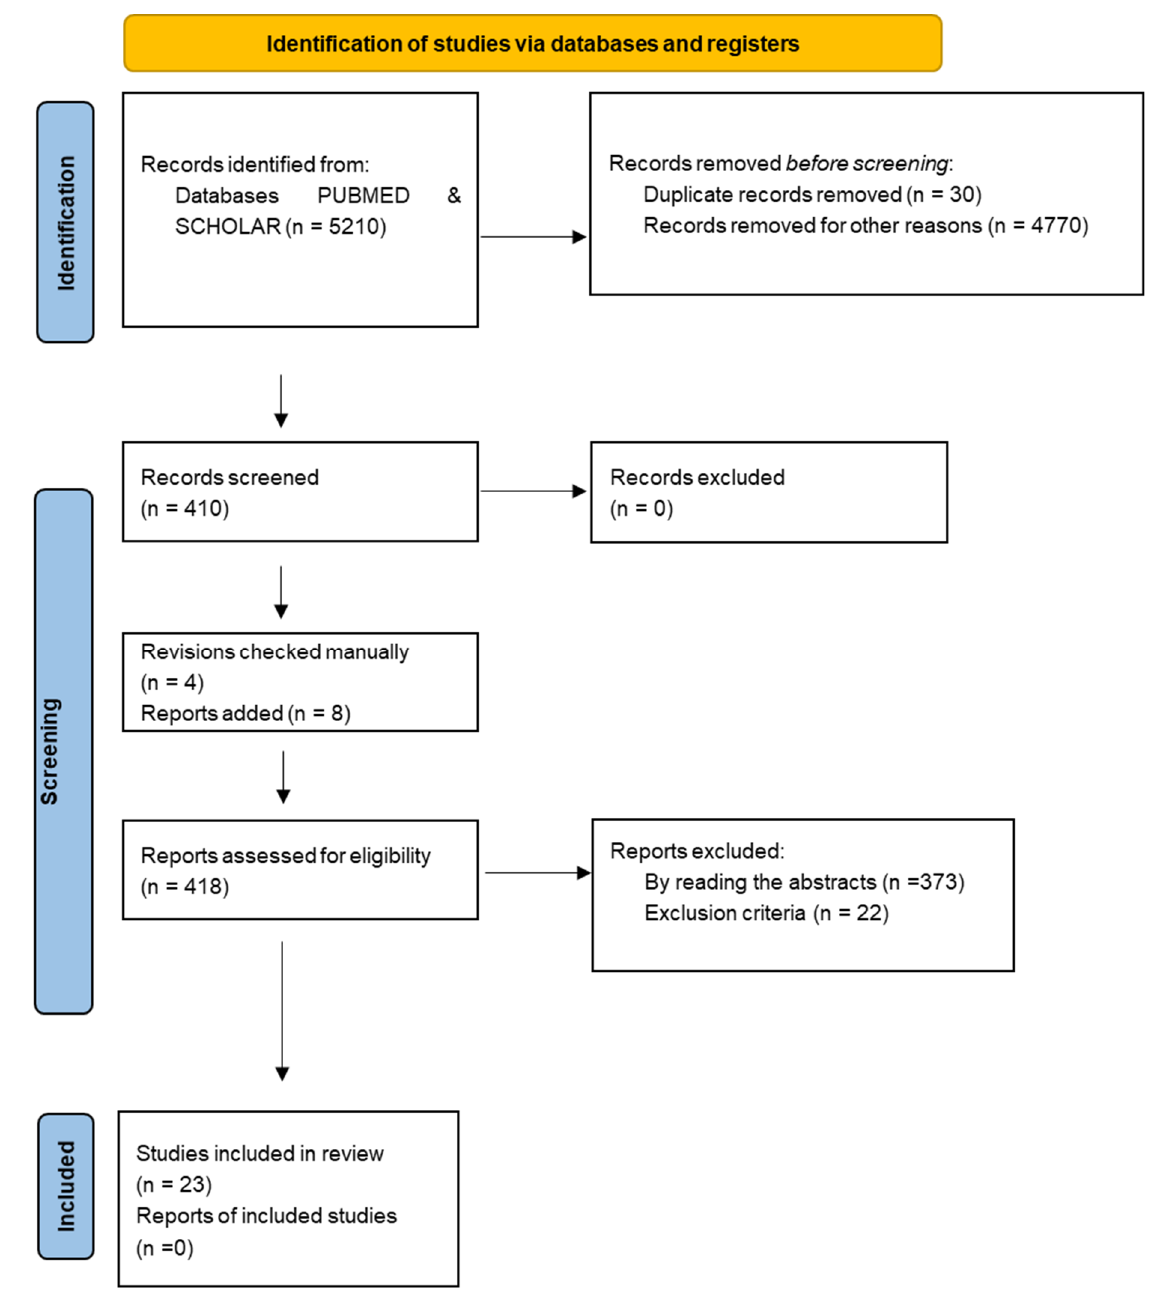
Figure 1. PRISMA flow diagram of article selection. From: Page MJ, McKenzie JE, Bossuyt PM, Boutron I, Hoffmann TC, Mulrow CD, et al. The PRISMA 2020 statement: an updated guideline for reporting systematic reviews [6].